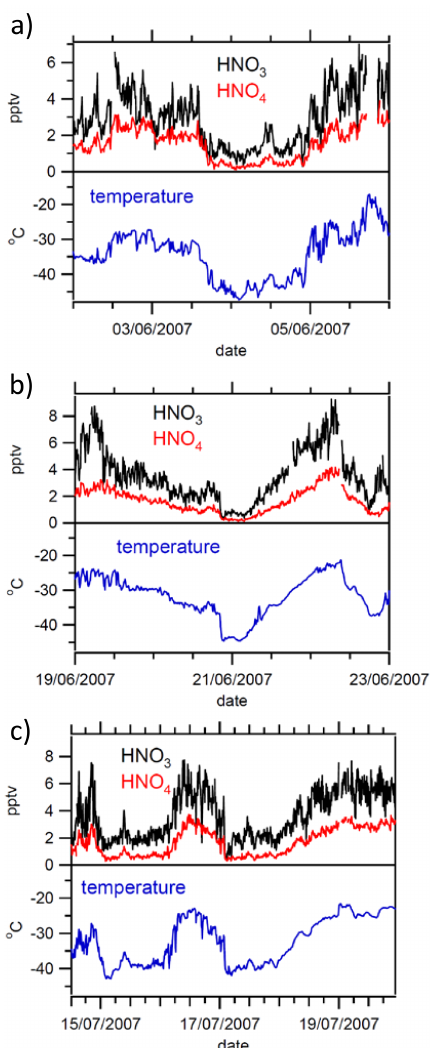
Figure 5. Three examples of short-term variability in HNO 3 , HO 2 NO 2 and ambient air temperature (10min data), from (a) early June; (b) mid June; and (c) mid July. All three periods are during the winter 24h per day